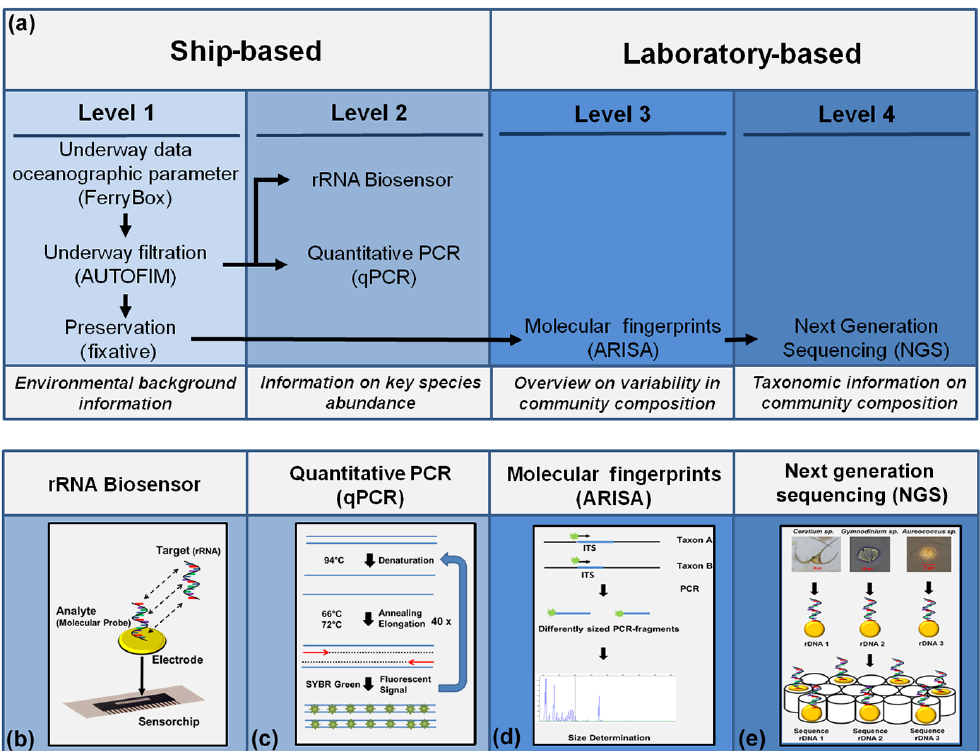
Figure 1. (a) Overview of the smart observation strategy which is organized into four different levels: level 1: samples are collected in transit or at monitoring sites using the remotely controlled automated filtration system AUTOFIM; level 2: direct molecular surveillance of key species aboard the ship via an automated biosensor system or quantitative polymerase chain reaction; level 3: preserved samples are analyzed via molecular fingerprinting methods (e.g., ARISA) that provide a quick and reliable overview of differences in protist community composition of the samples in a given observation area or time period; level 4: detailed analysis of taxonomic protist composition in selected samples via the latest next generation sequencing. (b–e) Schematic diagrams illustrating the analyses used in the smart observation